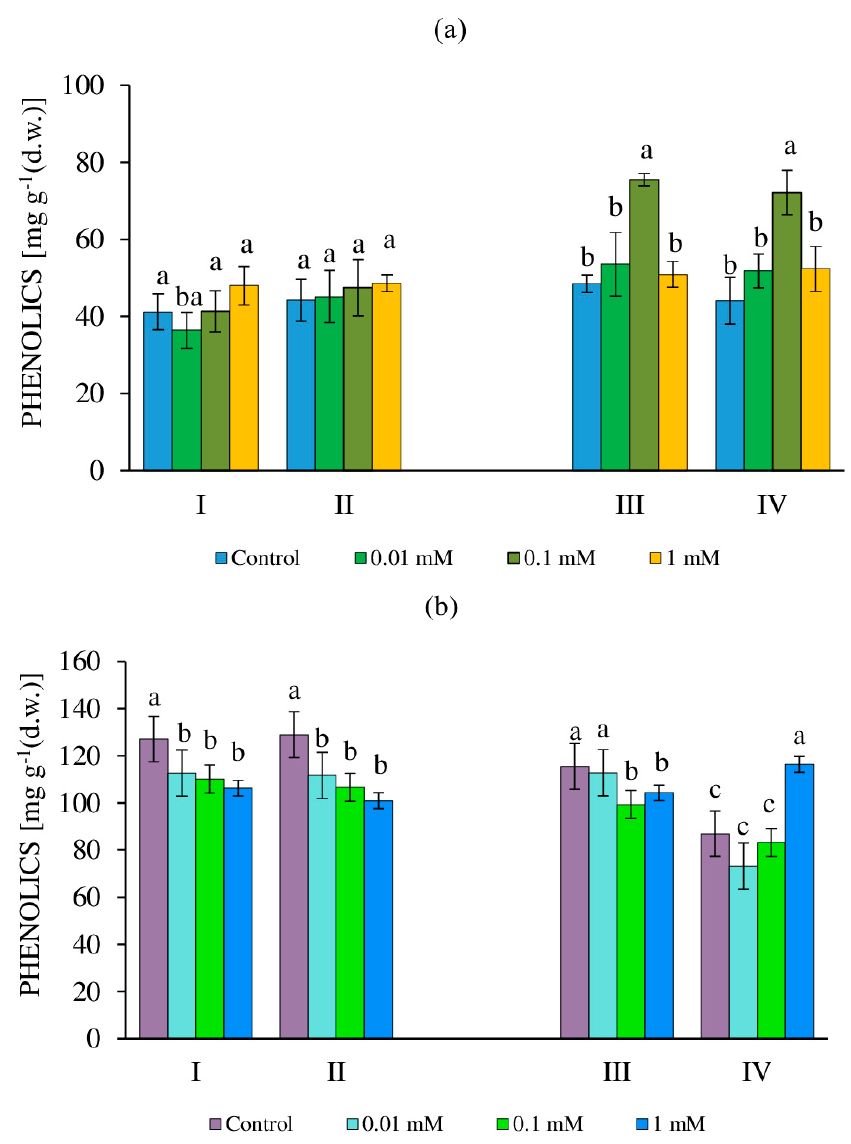
Figure 4. The content of the total phenolic compounds in callus cultures of tea plants at 24 days (I, II) and 36 days (III, IV) of age, grown in the dark ( a ) or in the light ( b ) and exposed to various concentrations of H 2 O 2 – 0 (control), 0.01 mM, 0.1 mM, and 1 mM. Variants: I, III – rapid response of callus cells (2 h exposure to H 2 O 2 ); II, IV – delayed response of callus cells (48 h after exposure to H 2 O 2 ). Different letters indicate significant differences between exposure conditions ( p ≤ 0.05).